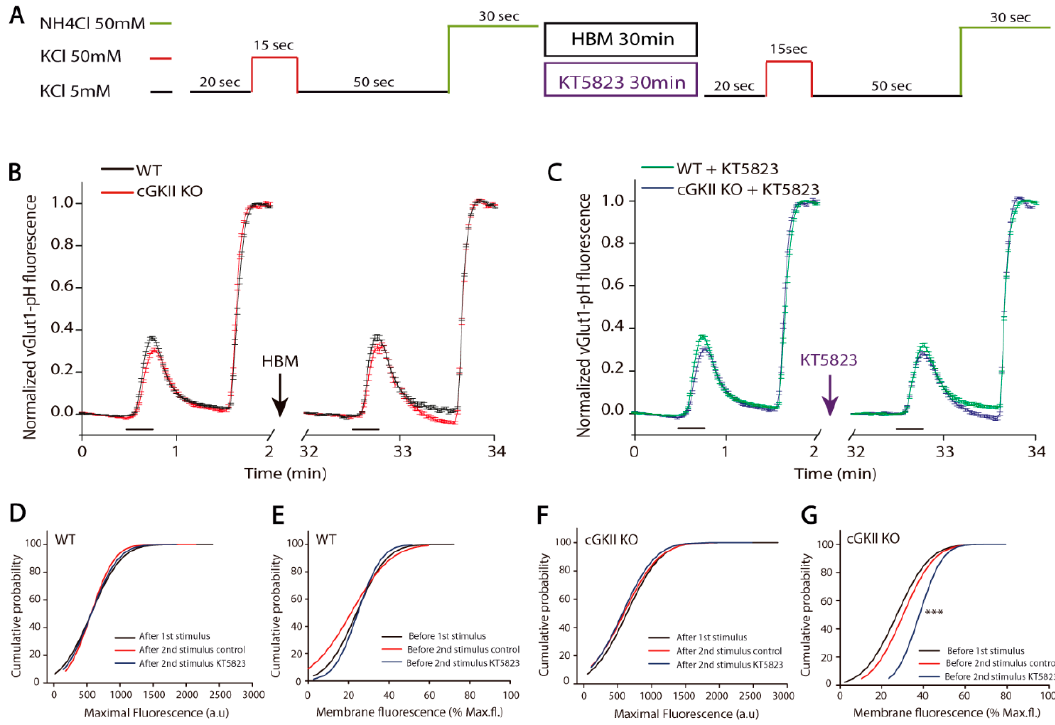
Figure 4. A dual stimulation protocol reveals important differences in the synaptic vesicle cycle in boutons from neurons lacking cGKII after KT5823 treatment. ( A ) Experimental protocol. ( B ) Mean traces of the KCl-elicited increase in vGluT1-phluorin fluorescence normalized to the NH 4 Cl-elicited fluorescence for all the boutons analyzed from WT ( n = 167 boutons, 4 coverslips from three different cultures) or cGKII KO neurons ( n = 114 boutons, 4 coverslips from three different cultures) perfused with HBM between the two stimuli. ( C ) Mean traces of the KCl-elicited increase in vGluT1-phluorin fluorescence normalized to the NH 4 Cl-elicited fluorescence for all the boutons analyzed from WT ( n = 153 boutons, 3 coverslips from three different cultures) or cGKII KO neurons ( n = 157 boutons, 3 coverslips from two different cultures) perfused with HBM containing KT5823 (1 µM) between the two stimuli. ( D ) Cumulative distribution of maximal fluorescence (obtained by a brief exposure to NH 4 Cl) after the first or the second stimulus in boutons from the WT cells represented in panel B and C. ( E ) Cumulative distribution of the membrane steady state fluorescence expressed relative to the maximum fluorescence before the first or the second stimulus ±KT5823 of boutons from the WT cells represented in panel B and C. ( F ) Cumulative distribution of the maximum fluorescence (obtained by a brief exposure to NH 4 Cl) after the first or the second stimulus in boutons from the cGKII KO cells represented in panel B and C. ( G ) Cumulative distribution of the membrane steady state fluorescence expressed relative to the maximum fluorescence before the first or the second stimulus of boutons from the cGKII KO cells represented in panel B and C (*** p = 0.0007, 2nd stimulus KT5823 vs. 1st stimulus, Mann–Whitney).